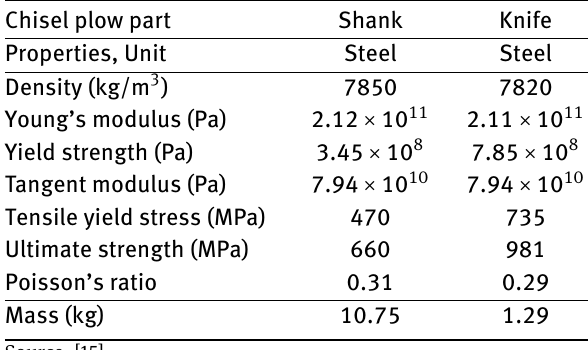
Table 1: Material properties of the original chisel plow Chisel plow part